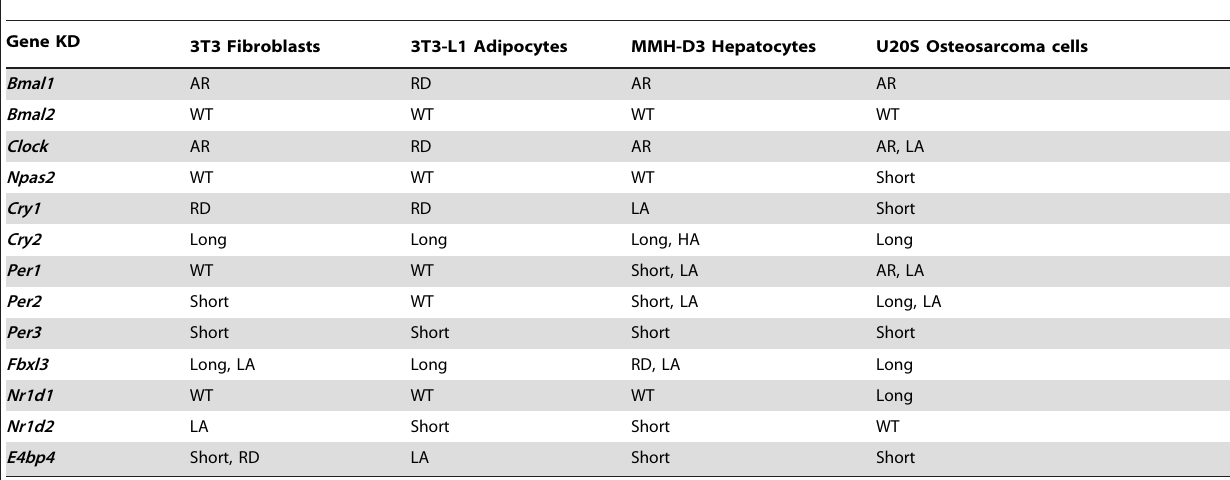
Table 1. Summary of knockdown